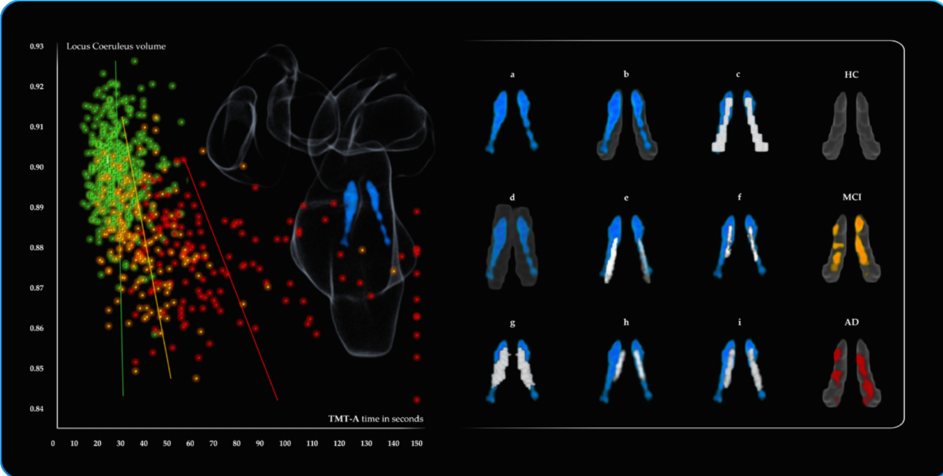
Figure 3. Results from the VBM multivariate linear regression analyses performed in CAT12 for the three groups (HC, MCI, AD). The results are covaried for total intracranial volume (TIV), age and education. The scatterplot displays the relationship between Locus Coeruleus (LC) volume (y axis) and TMT-A time in seconds (x axis) for the three groups: green (HC, n.395), orange (MCI, n.156), red (AD, n.135). On the x axis (TMT-A) are the seconds required to complete TMT-A. More seconds spent in completing TMT-A mirror a slower visuo-spatial cognitive processing related to the LC decline. The systematic decline of the LC volume across the three groups is related to a slower visuo-motor attentional performance. On the left portion of the figure, blue shows the average LC results for the three groups (n = 686, p < 0.001) on a 3D fronto-lateral view of the Brainstem and the Diencephalon. On the right portion of the figure are the 3D reconstructions (displayed in the MNI152 space) of the results in comparison with previously published LC atlases and masks. ( a ) average LC result; ( b ) average LC result is shown in the LC “omni-comprehensive” mask; ( c ) Keren et al. (2009) [102,107]; ( d ) Tona et al. (2017) [108]; ( e ) Betts et al. (2017) [109]; ( f ) Dahl et al. (2019) [33]; ( g ) Liu et al. (2019) [110]; ( h ) Rong Ye et al. (2020) [111]; ( i ) LC meta-mask by Dahl et al. (2021) [70]. The last column on the right shows the regions of the LC mask negatively related to TMT-A performances for the three groups considered separately ( p < 0.01): HC n = 395 (no results), MCI n = 156 and AD n =